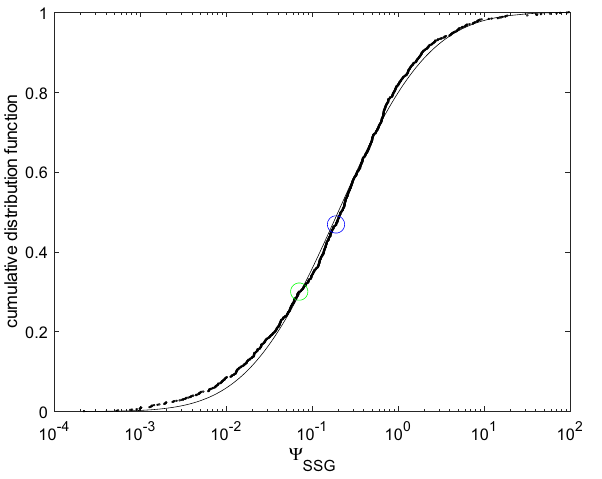
Figure 6. Cumulative distribution function for (cid:31) SSG and best fit using a normal distribution for log (� SSG ) (dash-dotted line). The blue and green circles correspond to the materials chosen for